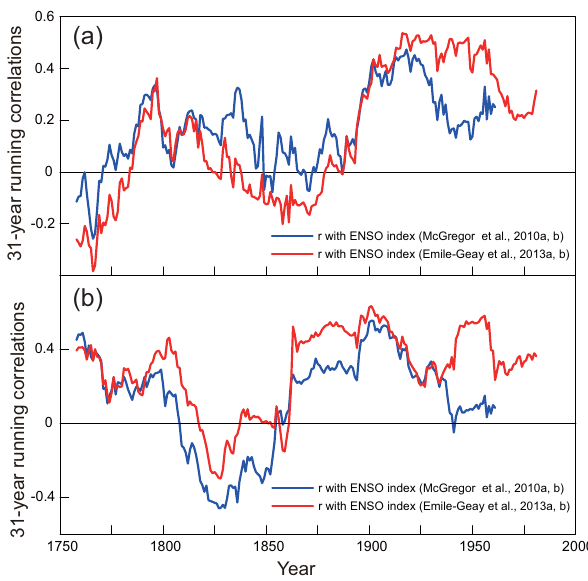
Figure 9. Thirty-one-year running correlations between two ENSO reconstructions and the H5 regional tree-ring δ 18 O record (a) , and Indian Ocean SST reconstruction (b) .